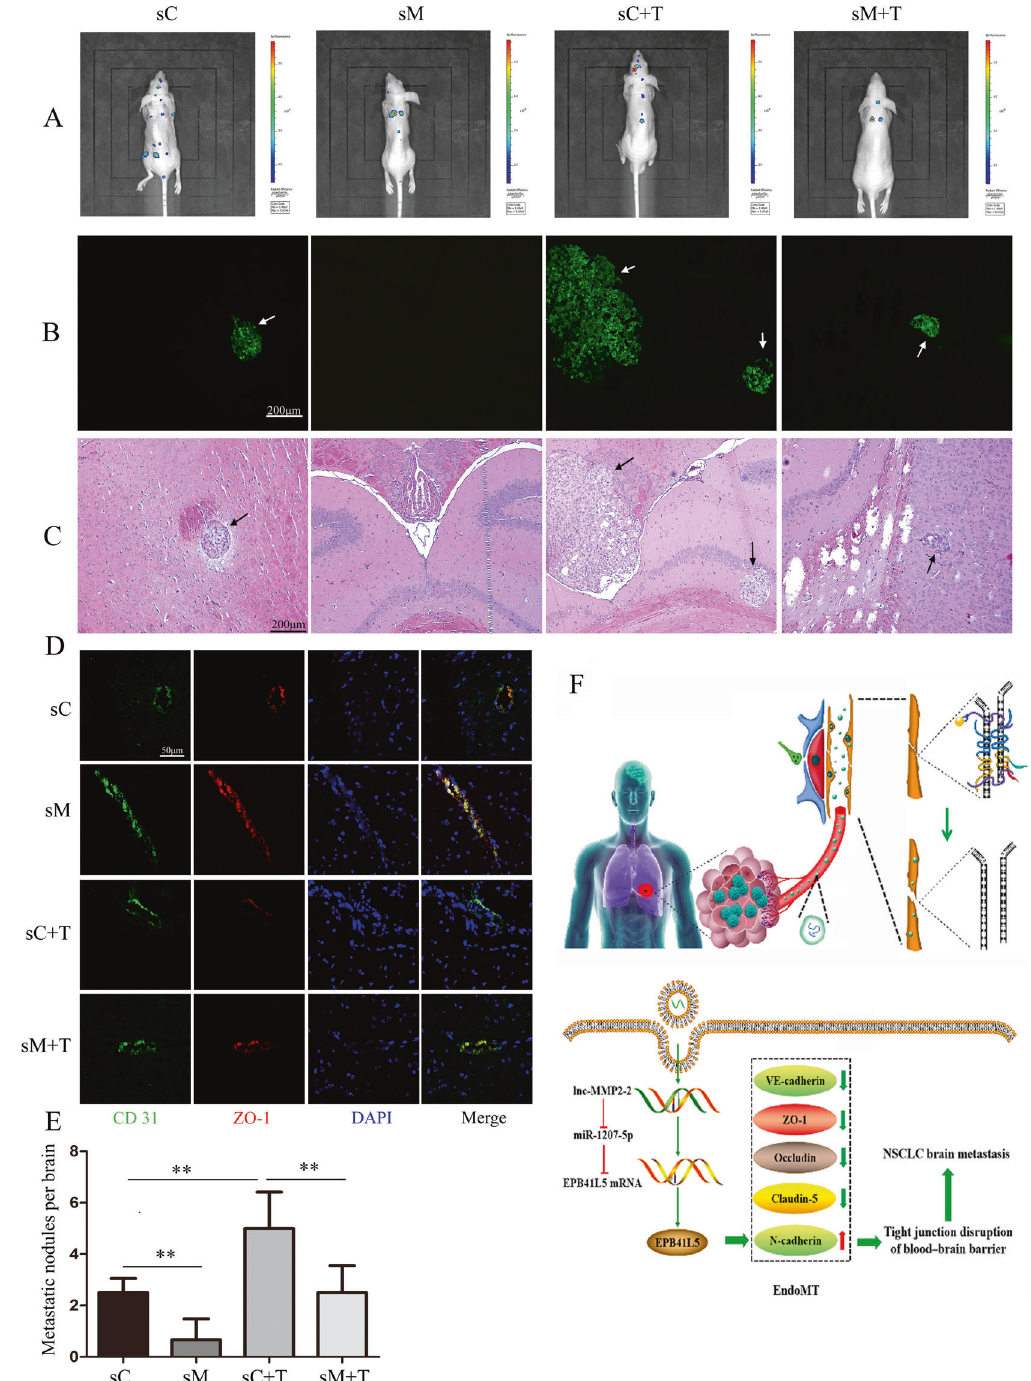
Fig. 7 lnc-MMP2-2 knockdown inhibits the NSCLC brain metastasis in vivo. A549 cells stably transfected with control and shlnc-MMP2-2 lentivirus and treated with or without 10 ng/ml TGF- β 1 for 24 h. All the cells are then injected into the heart of nude mice ( N = 6). Three weeks after the injection, mice are photographed and sacri fi ced. A Representative IVIS imaging in brain metastasis mice. B , C Representative bioluminescent images of brain metastases and paired HE images (scale bar, 200 μ m). D Brain tissues are subjected to double-label IF for analysis of ZO-1 (red) expression in CD31 + (green) endothelial cells (scale bar, 50 μ m). E The average number of metastatic nodules in the brain metastasis mice. ** p < 0.01. F Schematic of the proposed mechanism of action of the lnc-MMP2-2 /miRNA-1207-5p/EPB41L5 axis. A detailed description is shown in the main text. sC: shControl, sM: shlnc-MMP2-2, sC + T: shControl + TGF- β 1, sM + T: shlnc-MMP2-2 + TGF- β